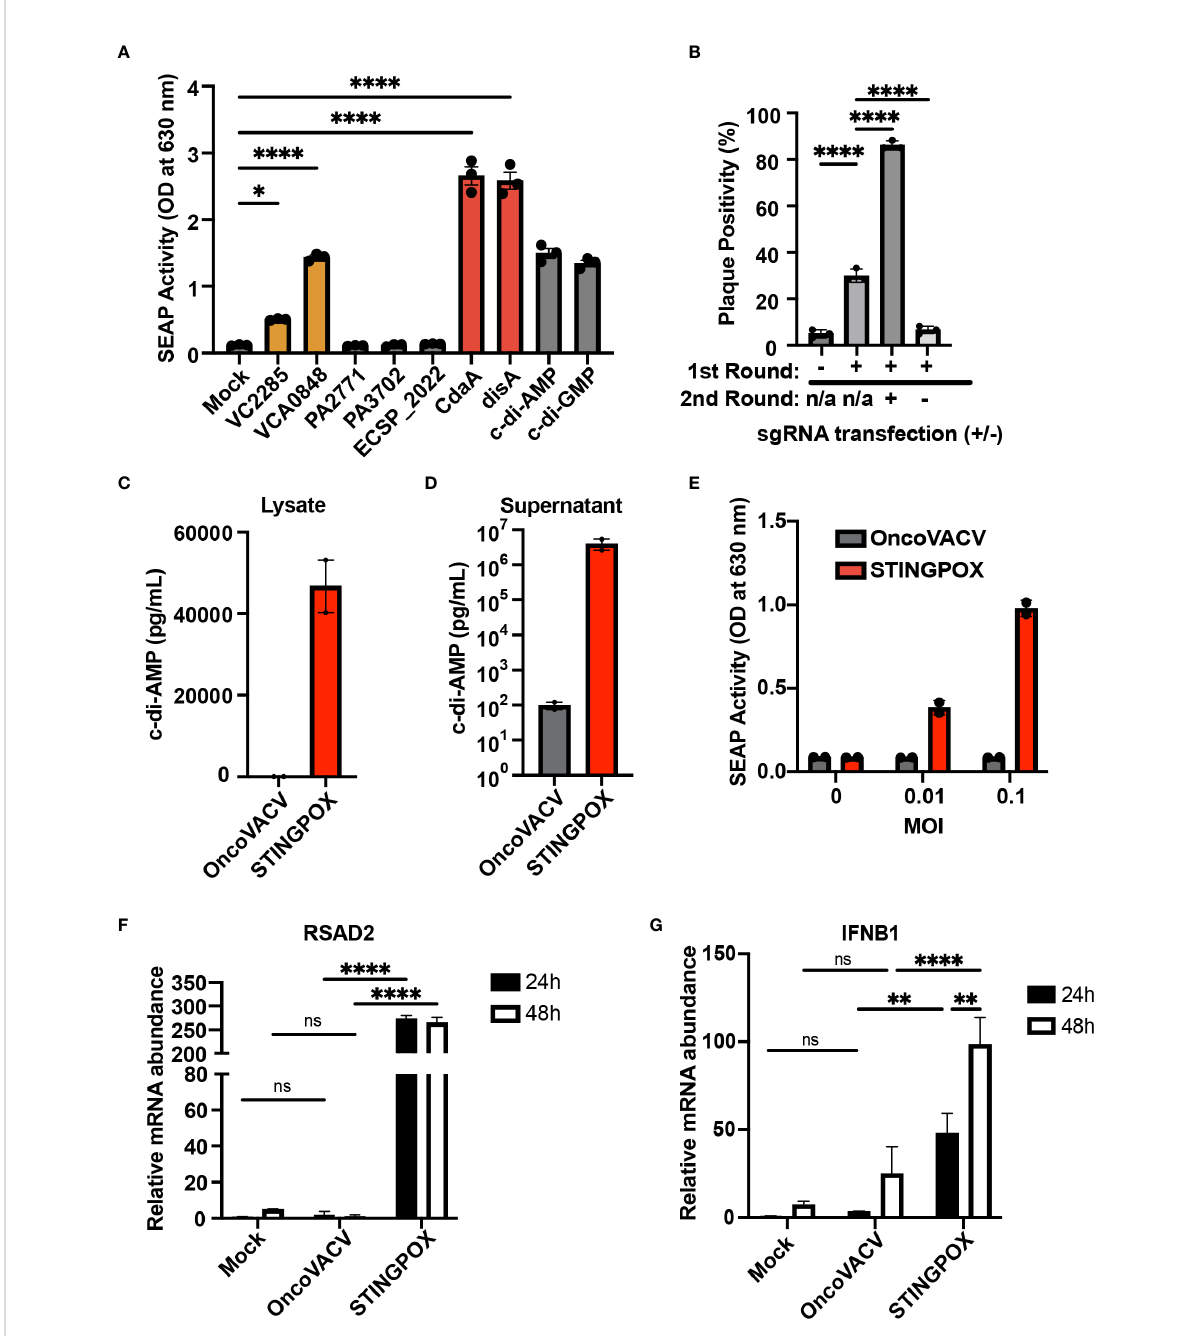
FIGURE 3 CARVE-mediated generation of novel immunotherapeutic STINGPOX. (A) Mammalian expression plasmid screen of bacterial cyclases. HEK293T were transfected with expression plasmids for noted cyclase and then lysed 24 hours post-transfection. Diluted clari fi ed lysates were then used to treat THP- Blue ISG cells, and SEAP reporter assay was performed to measure relative effect on IFN signaling (n=3). (B) CARVE-mediated rescue of OncoVACV +MtbDisA inserted at the B8R locus. Virus underwent traditional CARVE protocol with transfection of HRT encoding DisA (1st round) with or without sgB8R, virus produced with sgB8R in this step underwent a second round of selection where sgB8R was transfected alone, following infection. Resulting virus was used to infect con fl uent U2OS and plaques were scored for EGFP fl uorescence (n = 3). (C, D) Cyclic di-AMP ELISA was used to measure cyclic di-AMP levels in HeLa cell (C) lysates and (D) supernatants - 48 hours post-infection with STINGPOX or OncoVACV (n = 3). (E) 293-Dual hSTING- R232 cells SEAP reporter assay was performed to measure effects of infection with STINGPOX or OncoVACV on IFN signaling (48 hours post-infection; n = 3). (F, G) qRT-PCR analyses of relative (F) IFNB1 and (G) RSAD2 mRNA levels in HT29 cells, 48 hours-post infection with STINGPOX or OncoVACV (MOI = 0.1; n ≥ 2). Data are shown as mean ± SEM (p* < 0.05, p** < 0.01, p**** < 0.001), not signi fi cant